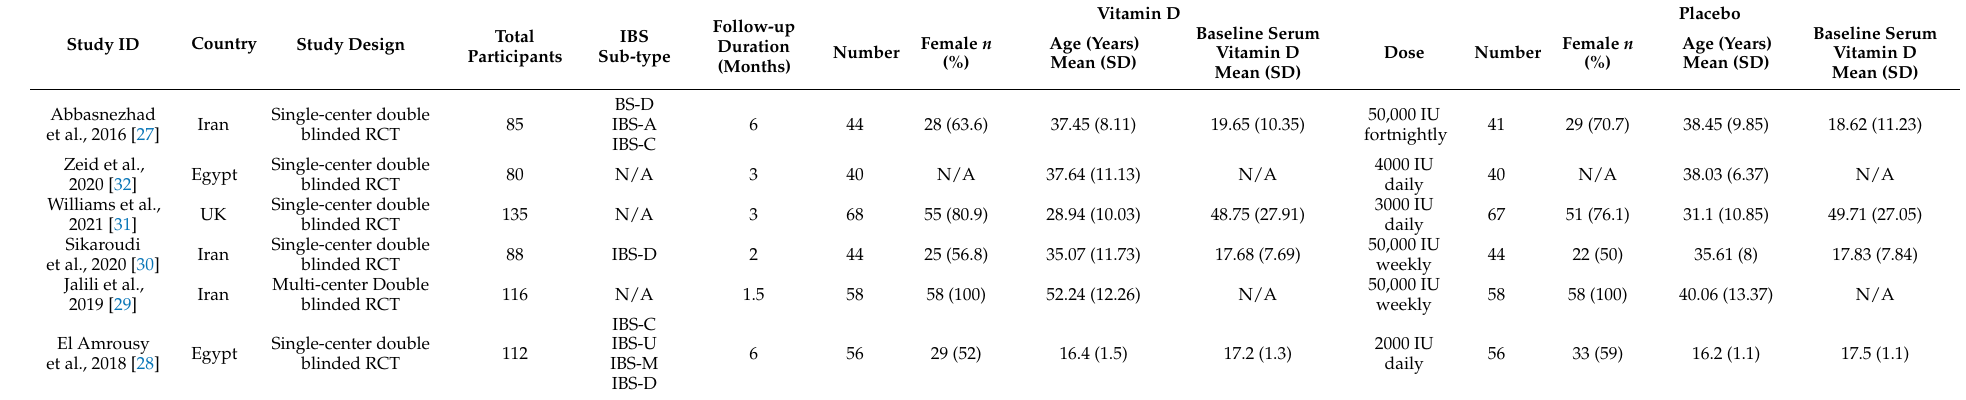
Table 2. Characteristics of the included